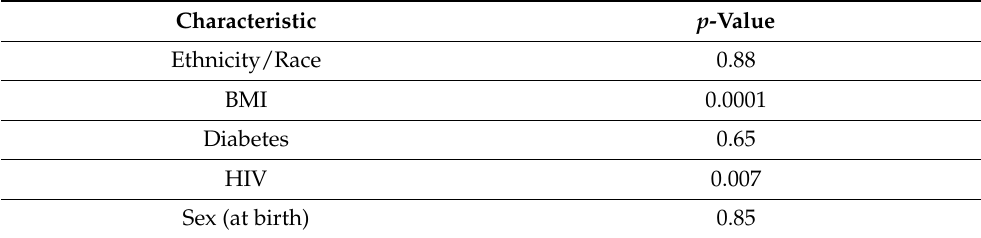
Table 2. Regression model of factors associated with steatosis.